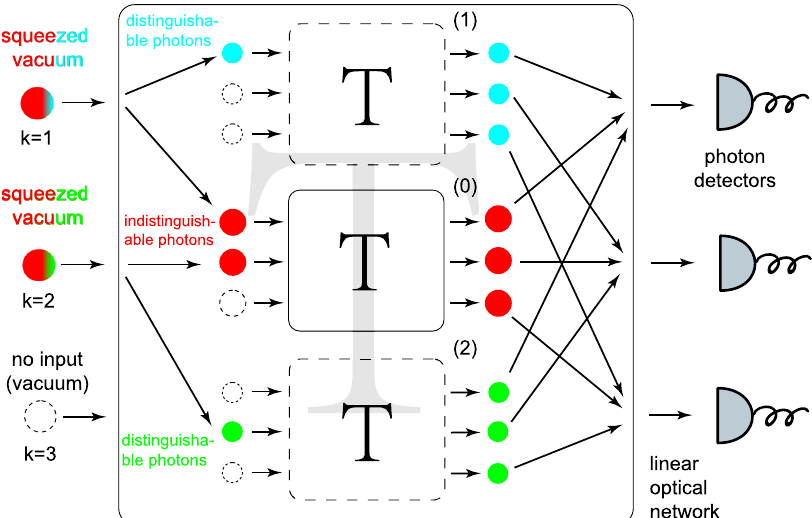
Fig. 1 A pictorial representation of the proposed model for GBS with partial distinguishability. For the simplicity of illustration, we show a 3 × 3 interferometer ( K = 3) characterized by T with input light at fi rst two ports ( M = 2). When partially distinguishable input light (represented by the mixed color ball for the input ports) enters the interferometer, they decompose into non-interfering modes and propagate inside the interferometer independently until they leave the interferometer and collectively meet the detectors at the output ports. The thin solid-lined rectangle represents the interferometer for the indistinguishable photons. The dashed rectangles represent the interferometer for the distinguishable virtual modes.